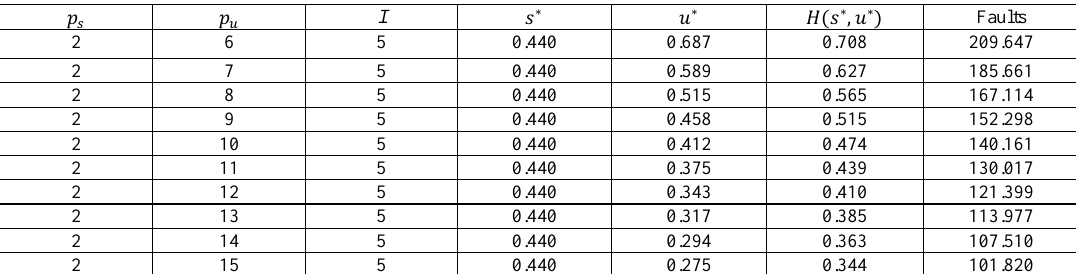
Table 4. The result of sensitivity analysis